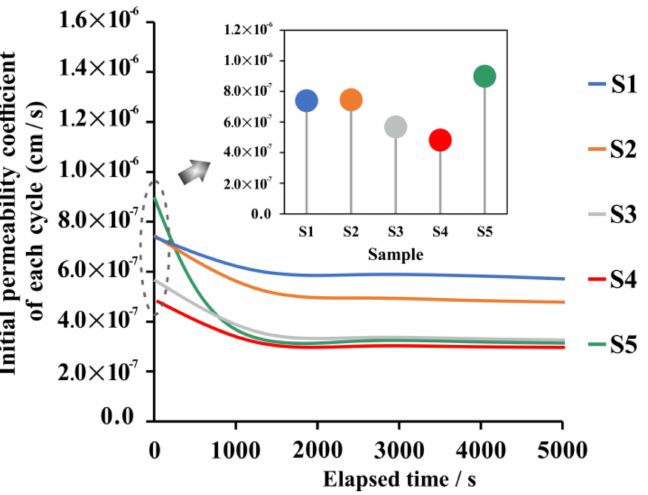
Figure 6. Initial value of permeability coefficient during different cycles of soil